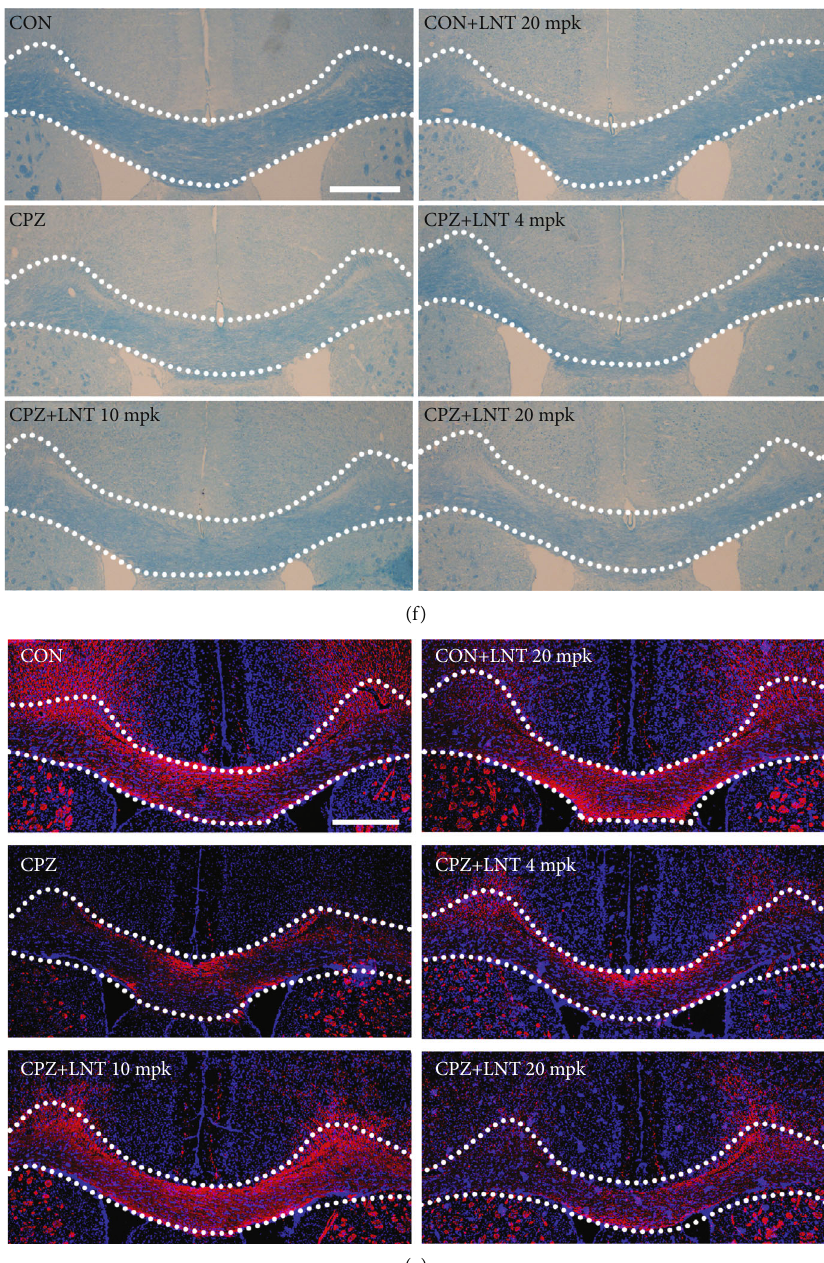
Figure 4: LNT ameliorated CPZ-induced motor dysfunction and demyelination in the CPZ model. (a) Scheme of the experimental protocol of LNT treatment. (b) E ff ects of LNT on the body weight in CPZ model. (c) Rotarod test. The latency time of each group to stay on the rotarod was recorded. (d) A histogram of quantitative data of the LFB-positive area in the corpus callosum. (e) A histogram of quantitative data of MBP immunostaining in the corpus callosum. (f) Representative images of LFB staining in the corpus callosum. (g) Immunostaining of MBP in the corpus callosum. All data are presented as the mean ± SEM . Scale bar = 200 μ m (f, g). Statistical analysis was performed using one-way ANOVA followed by the post hoc Tukey tests. ( ∗ P < 0 : 05 , ∗∗ P < 0 : 01 , and ∗∗∗ P < 0 : 001 ment with LNT, compared with the control group, CPZ- e ff ect on Olig2 ( P < 0 : 01 ) and Iba-1 ( P < 0 : 01 ). Lam inter- treated mice showed signi fi cantly increased iNOS (a marker vention signi fi cantly reversed the reduce induced by LNT of M1 microglial cells) ( P < 0 : 01 ), TNF- α ( P < 0 : 05 ), and IL- administration (Olig2, P < 0 : 05 and Iba-1 P < 0 : 05 ). 1 β ( P < 0 : 001 ) expression levels in the corpus callosum. How- Western blot analyses were performed to determine the ever, LNT show obvious inhibitory e ff ect on iNOS ( P < 0 : 01 ), expression levels of proin fl ammatory and anti-in fl ammatory TNF- α ( P < 0 : 001 ), and IL-1 β ( P < 0 : 05 ), while blocking cytokines in the corpus callosum of mice. After 7 days of treat-